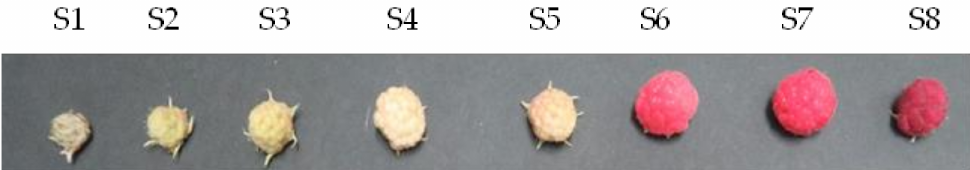
Figure 1. Maturation stages S1–S8 of the raspberry fruit. The stages were classified according to the number of days elapsed from the day when the flower buds bloomed (day 1); S1: 6–9 d; S2: 10–14 d;